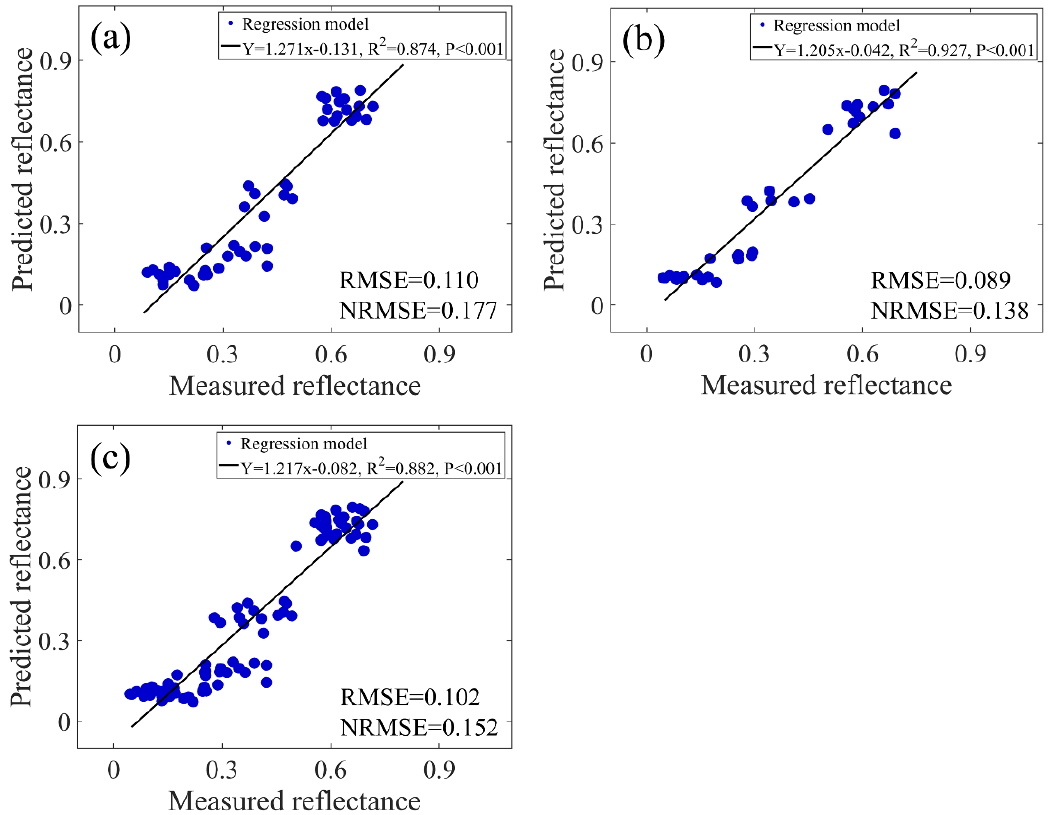
Figure 5. The linear regression using reflectance of maize from multi-spectral images and ASD-HH2, using data acquired on 5 August ( a ), 21 September ( b ), and on both days ( c ). Table 4. The results of linear regression analysis between spectral indices and SPAD values of the entire growing season. The first column indicates the name of spectral indices, the second column is the linear regression equations, and the third and fourth columns are the R 2 and p , respectively. Spectral Indices Linear Regression Equations R 2 p NDRE Y = 31.07X + 62.76 0.412 p < 0.001 RECI Y = 38.74X + 12.60 0.389 p < 0.001 ENDVI Y = 59.29X − 14.00 0.352 p < 0.001 DATT Y = 24.16X + 53.00 0.411 p < 0.001 NGI Y = 90.11X − 127.24 0.332 p < 0.001 MCARI Y = 42.40X + 30.29 0.381 p < 0.001 MRGBVI Y = 60.76X – 14.77 0.328 p < 0.001 MRNRVI Y = 30.01X + 9.92 0.376 p < 0.001 MTCI Y = 39.96X + 9.74 0.375 p < 0.001 MDD Y = 50.67X + 58.37 0.399 p <